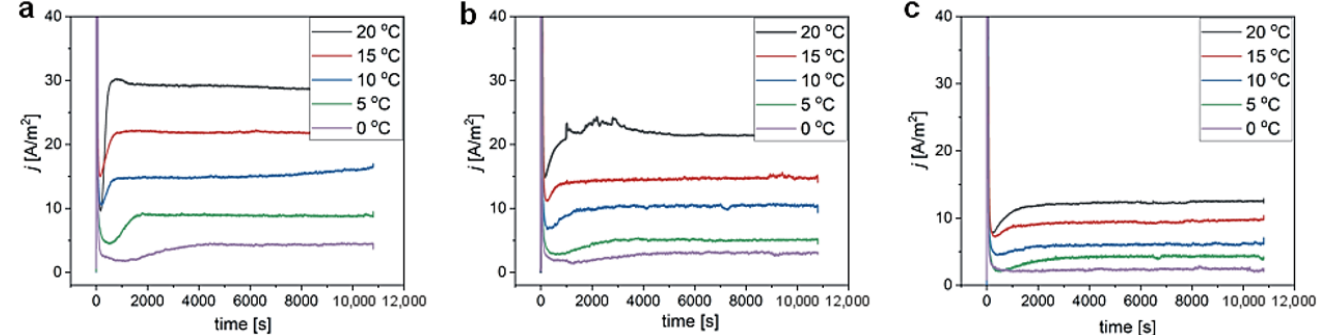
Figure 5. Current density (j) vs. time curves recorded during II anodization at 210 V at various temperatures in 0.3 M etidronic acid solutions without ethanol ( a ), and in the 1:9 v / v EtOH:H 2 O ( b ) and 1:3 v / v EtOH:H 2 O ( c ) mixtures.